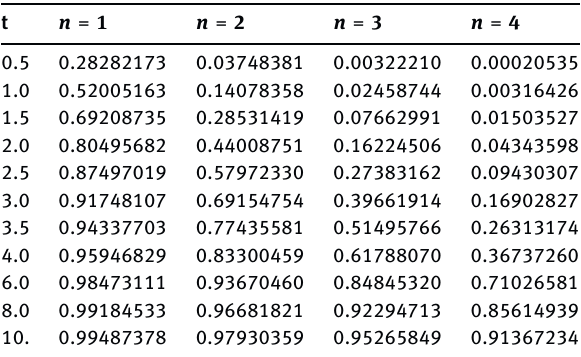
Table 17: Obtained values of y ( t ) by the present method for various values of n and t